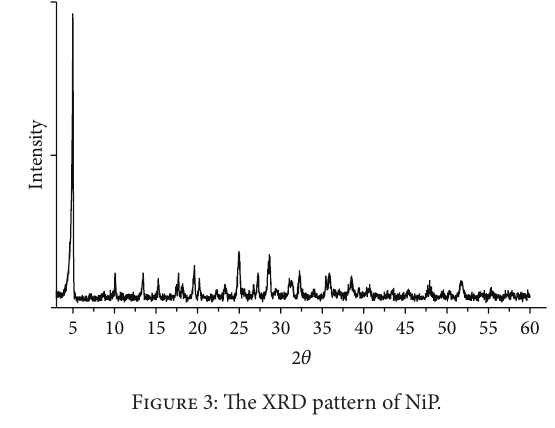
Figure 3: The XRD pattern of